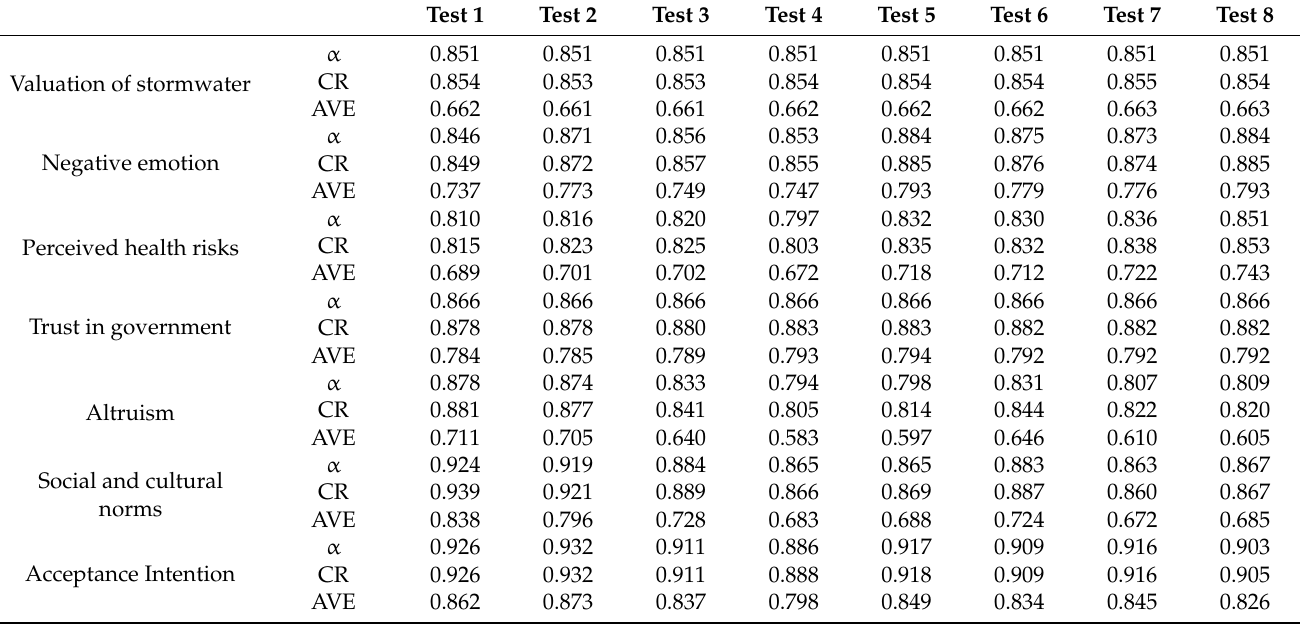
Table 1. Reliability and validity of the measurement model.